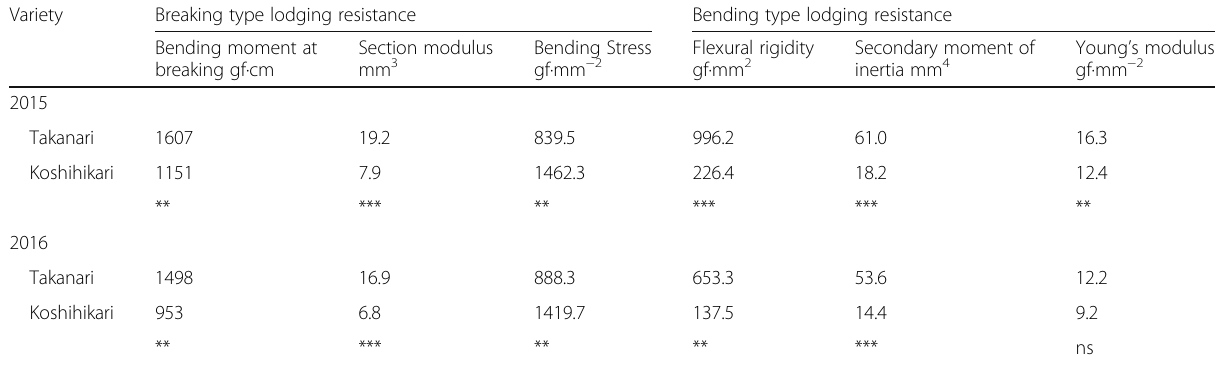
Table 1 Breaking and bending type lodging resistance of Koshikari and Takanari in 2015 and 2016 Variety Breaking type lodging